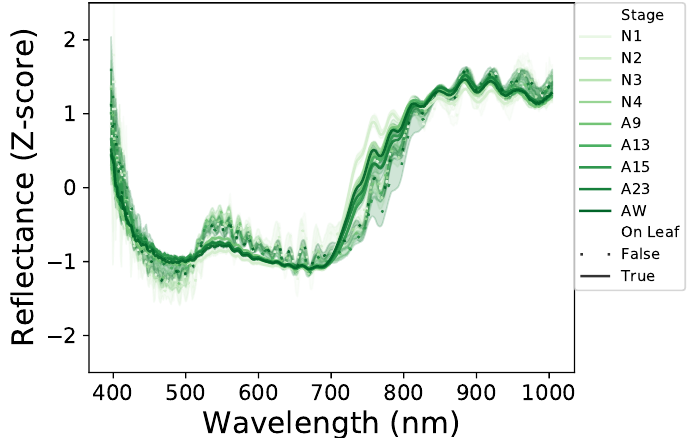
( d ) Z-score and white–dark normalized spectra of A. pisum LL01 (green aphids). Figure 3. Cont. Figure 3. Cont